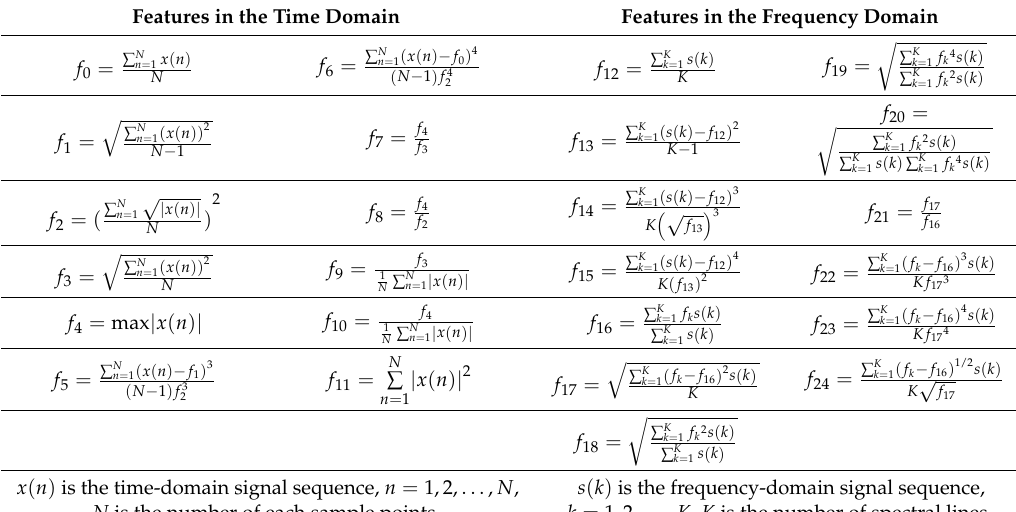
Table 1. Features in the time domain and frequency domain